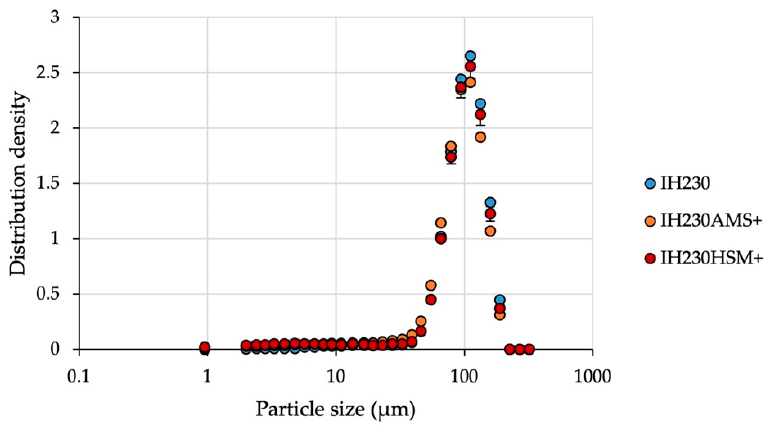
Figure 4. Particle size distribution density of the raw material in comparison to processed powders with the additive. n = 3, error bars show SD.